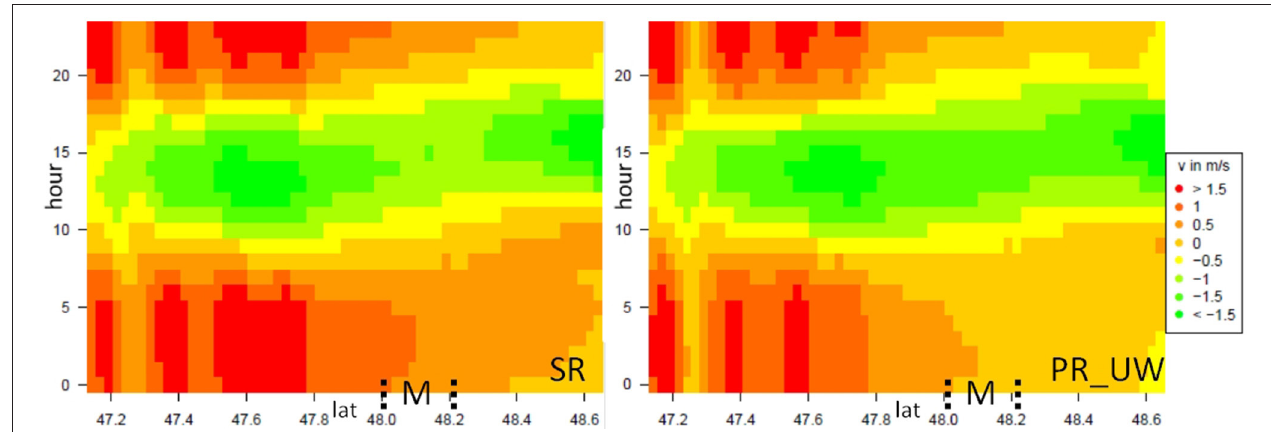
FIGURE 6 | Latitude-time sections of the southerly surface wind component at the longitude of Munich, averaged over 5 grid cells in zonal direction for the SR criterion (left) and the PR_UW combination (right).